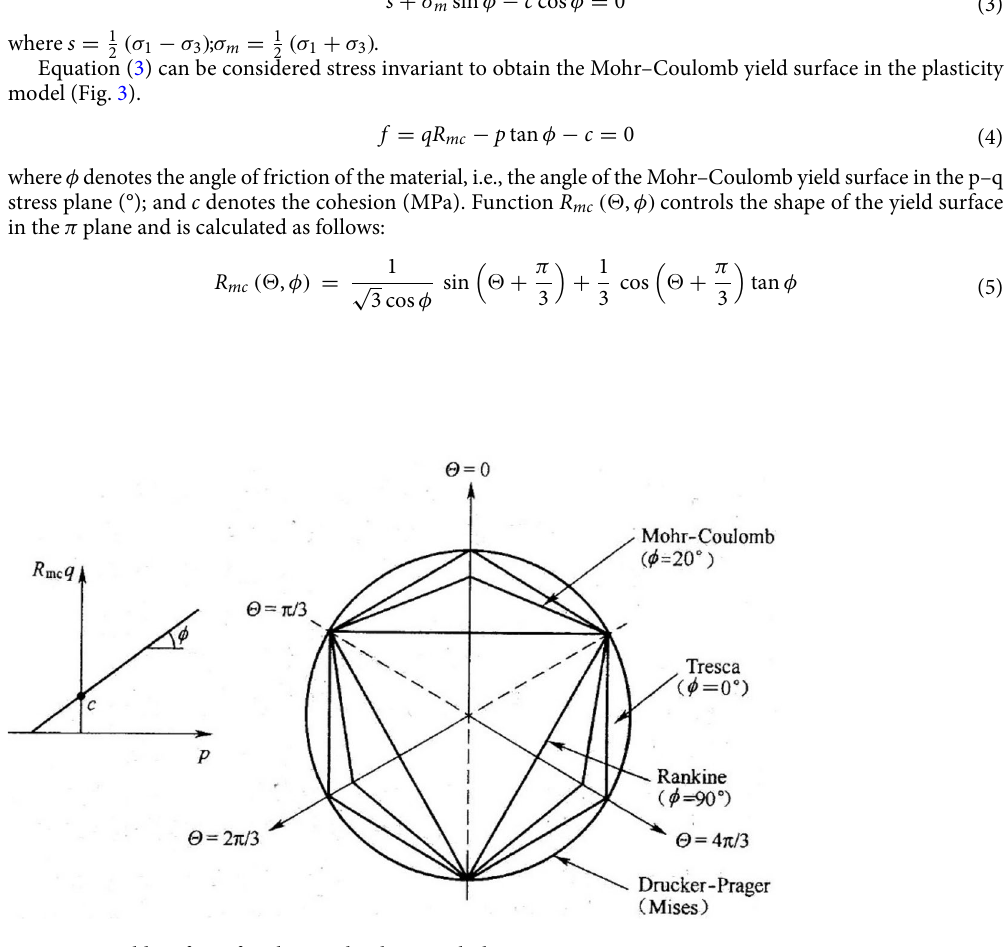
Figure 3. Yield surface of Mohr–Coulomb strength